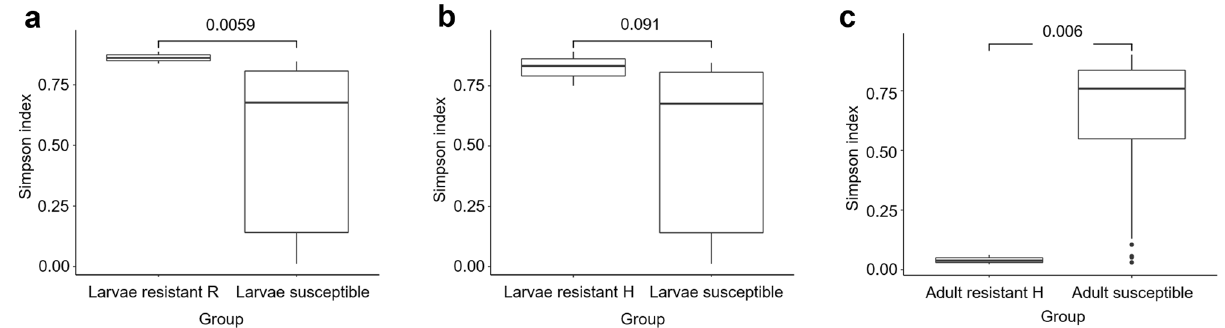
Figure 4. Alpha diversity boxplots designed with Simpson index was used to compare the gut microbiome between SBV-resistant and -susceptible honey bee strain. The comparison of microbiome between larvae of resistant strain R and that of susceptible strain ( a ), and between resistant strain H and susceptible strain ( b ). The difference in gut microbiome between adult bee of resistant train H and susceptible strain was also shown ( c ).